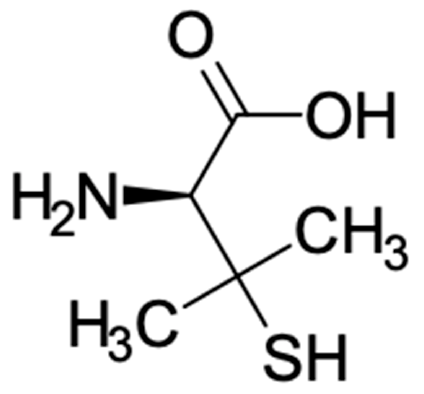
Figure 1. Structure of D-penicillamine.